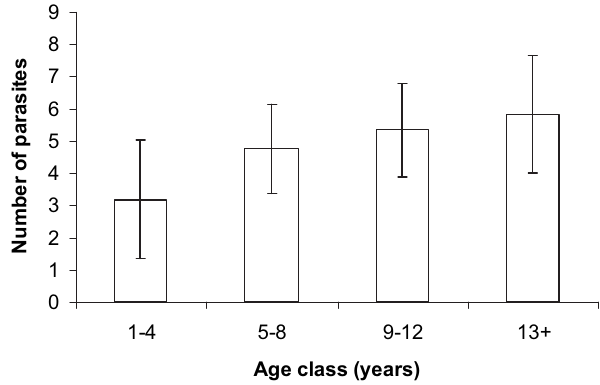
Fig. 2. – Mean number (± 1 standard deviation) of parasite species plotted against age of shorthorn sculpin from Peterhead Inlet and the Sylvia Grinnell estuary, Nunavut.